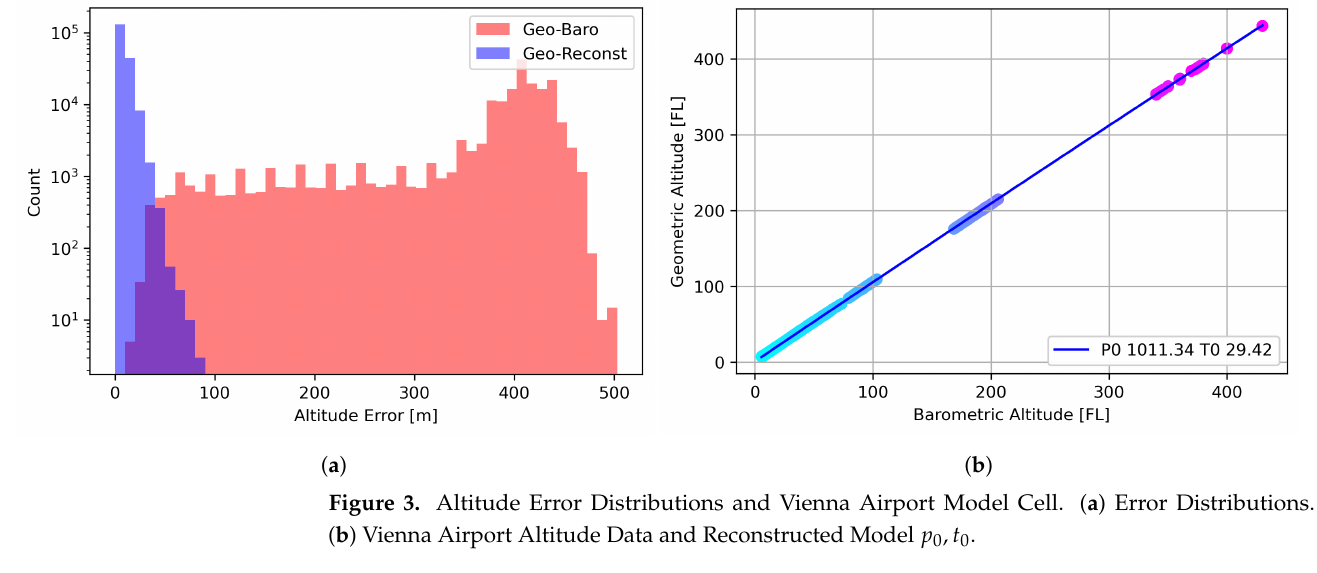
Figure 3. Altitude Error Distributions and Vienna Airport Model Cell. ( a ) Error Distributions. ( b ) Vienna Airport Altitude Data and Reconstructed Model p 0 , t 0 .